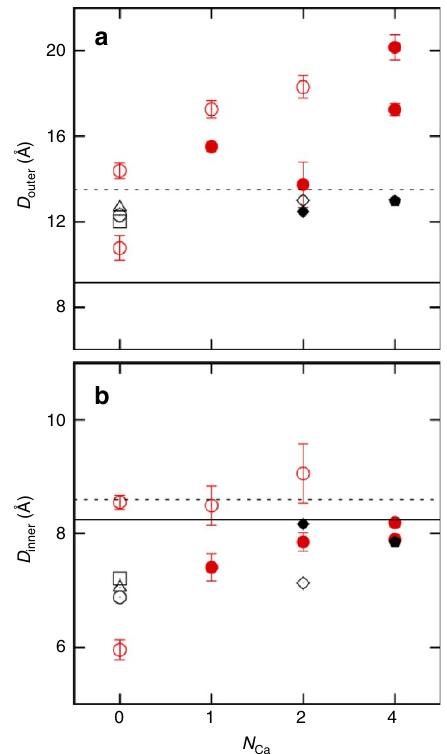
Figure 5 | Outer and inner diameters of the selectivity filter pore in the NaKTs channel. ( a ) The outer diameter D outer taken as the C a –C a distance between the diagonally placed Pro68 is shown. ( b ) The inner diameter D inner taken as the C a –C a distance between the diagonally placed Pro63 is shown. Supplementary Fig. 4 shows the relative positions of the proline residues. The diameters from the NaKTs channel crystal structures are presented by black symbols. They are grouped by the number of Ca 2 þ at the selectivity filter S Ca site. States I ( and n ) and II ( & ) have no Ca 2 þ at the S Ca site. Two structures are used for State I. The difference between the two lies in that the second structure ( n ) has a Ca 2 þ in the centre of the intracellular vestibule. State III ( and ~ ) has two Ca 2 þ at the diagonally place S Ca sites; State IV ( has all four S Ca sites occupied. The averaged D outer and D inner in the MD simulations ( (cid:2) 500mV) are plotted with red symbols. The error bars indicate the standard deviations of the distances calculated from the trajectories. The distances are calculated from two pairs of diagonally placed subunits. In all cases, filled symbols indicate that the distance is taken from subunits with the S Ca sites occupied by Ca 2 þ . The D outer and D inner in the NaK channel (2AHY, solid line) and KcsA (1K4C, dotted line) are shown as